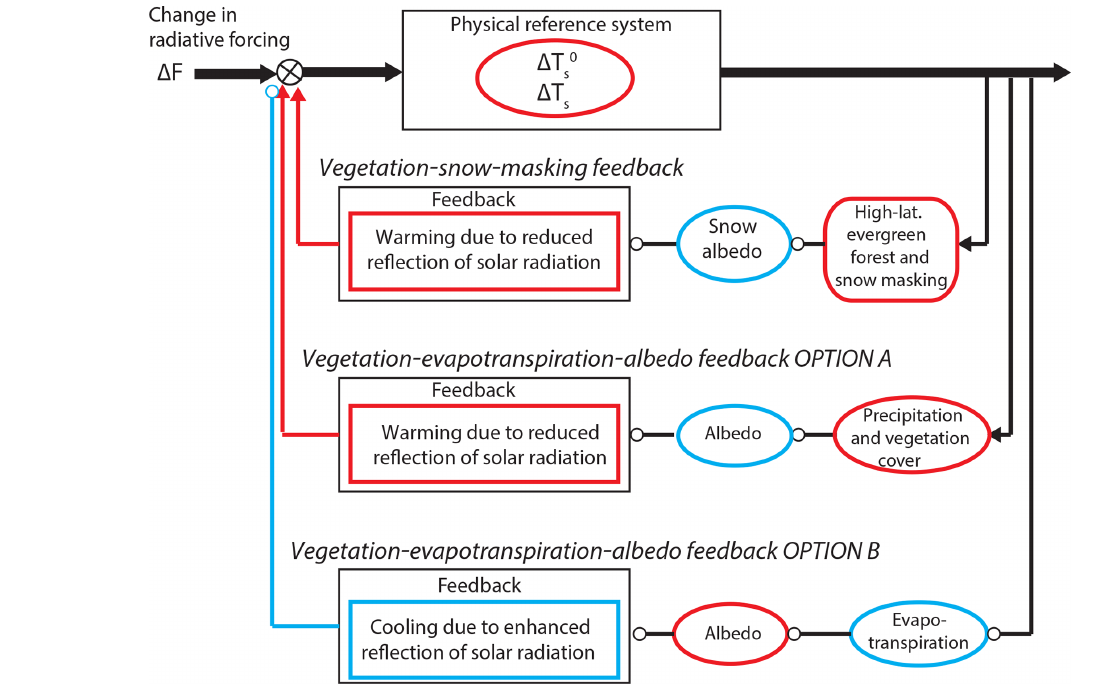
Figure 10. Schematic of important slow land surface feedbacks. The sign of the vegetation–evapotranspiration–albedo feedback can be positive if, for example, a desert starts to green due to increased precipitation. It can, however, also be negative in the case of progressing desertification (or due to extreme developments such as an Amazonian forest dieback). Arrows indicate positive coupling; open circles indicate negative coupling. Changes in state variables are indicated by ellipses, changes in processes by rounded rectangles. Red indicates increasing values of variables, strengthening of processes, or positive feedbacks; blue indicates the opposite. The change in surface air temperature (cid:49)T s in the presence of feedback is different from the change (cid:49)T 0 s without feedback (see Sect. 2.2).